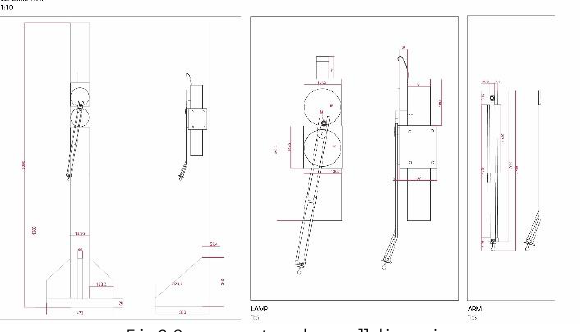
Fig.2.Components and overall dimension